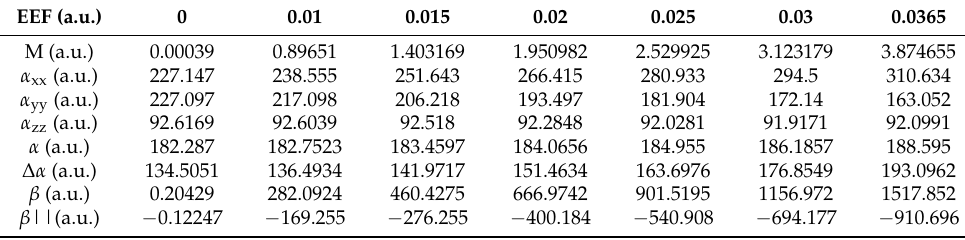
Table 3. Various polarization data under different external electric fields